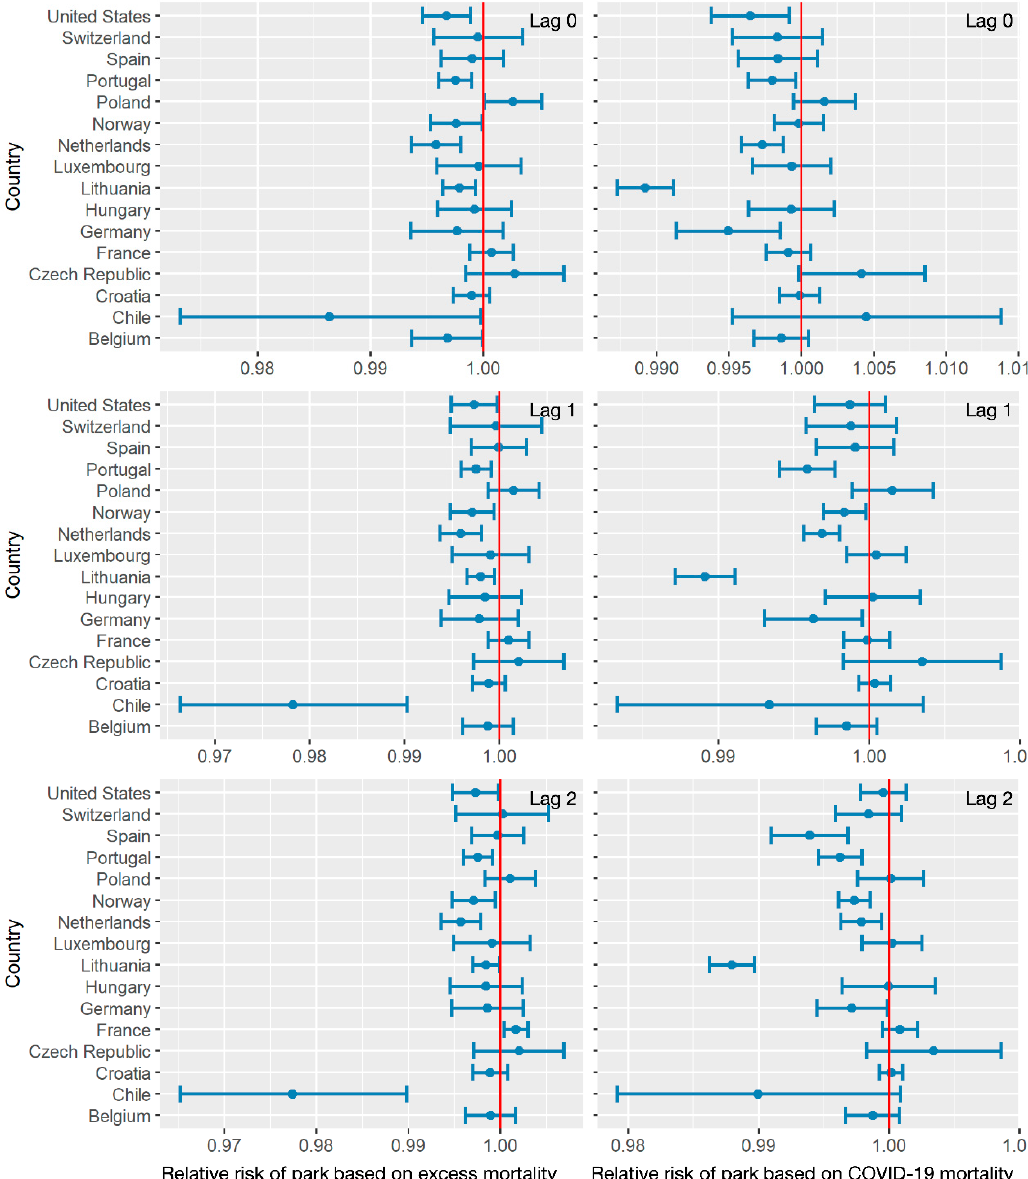
Figure 7. The relative risks of park visit frequency, related to excess mortality and COVID-19 mortality with lag effects of 0,1, and 2 weeks.